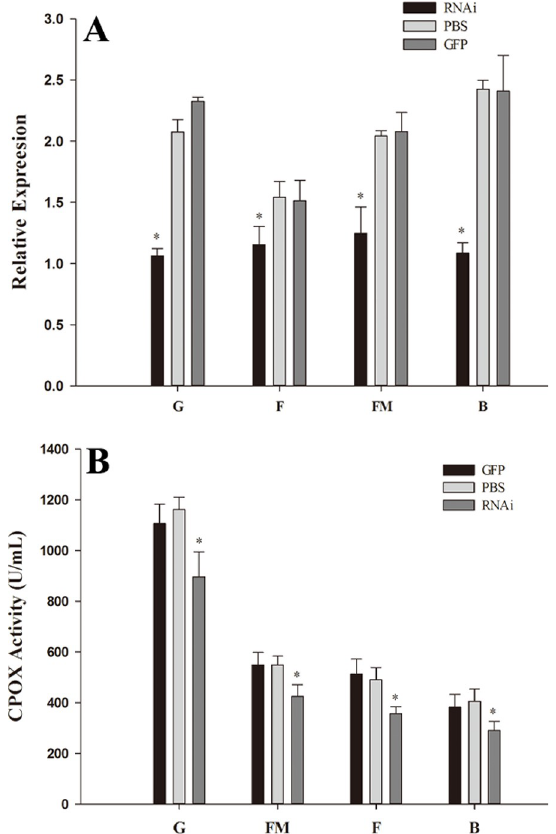
Fig 6. Effects of HcCPOX knockdown by RNAi. A, RNAi attenuated HcCPOX expression after RNAi. B, RNAi attenuated coproporphyrinogen-III oxidase activity after RNAi. G, gill; FM, fringe mantle; F, foot; B, hemolymph.